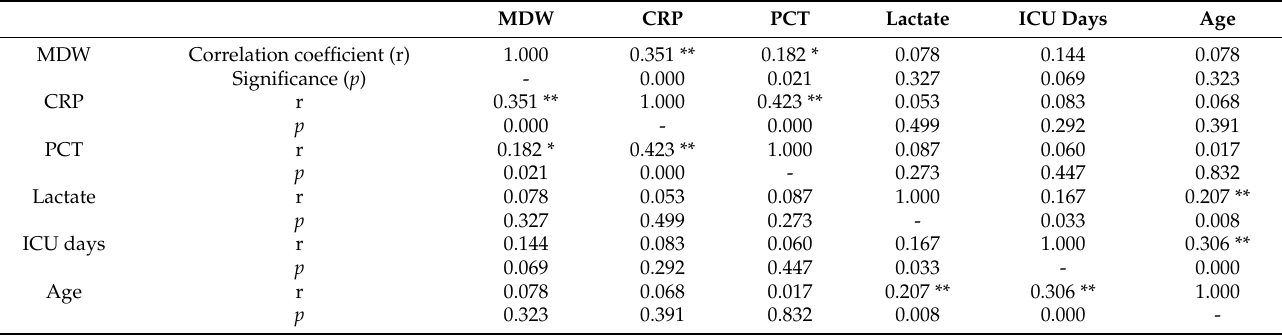
Table 5. Comparison between survived and deceased in average age, SOFA score, requirements for mechanical ventilation, and onset of shock in first 24 h.